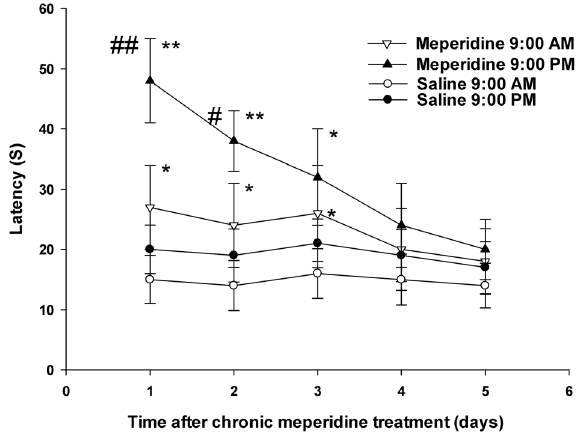
Figure 3. Influence of dosing time on tolerance after 5-day meperidine injection at day or night. Full legend: Influence of dosing time on tolerance to analgesia at 30 min after 5-day meperidine or saline injection at 9:00 am or 9:00 pm. Each value represents the mean with SD. * P , 0.05, ** P , 0.01 compared with the corresponding saline group, and # P , 0.05, ## P , 0.01 comparison between two dosing time using Scheffe’s test.